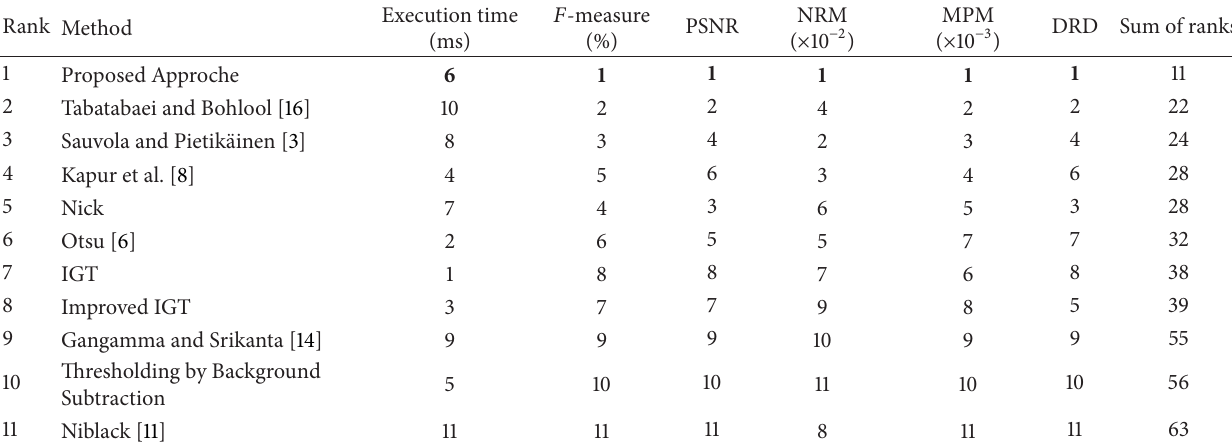
Table 3: Final ranking of the compared methods on the test